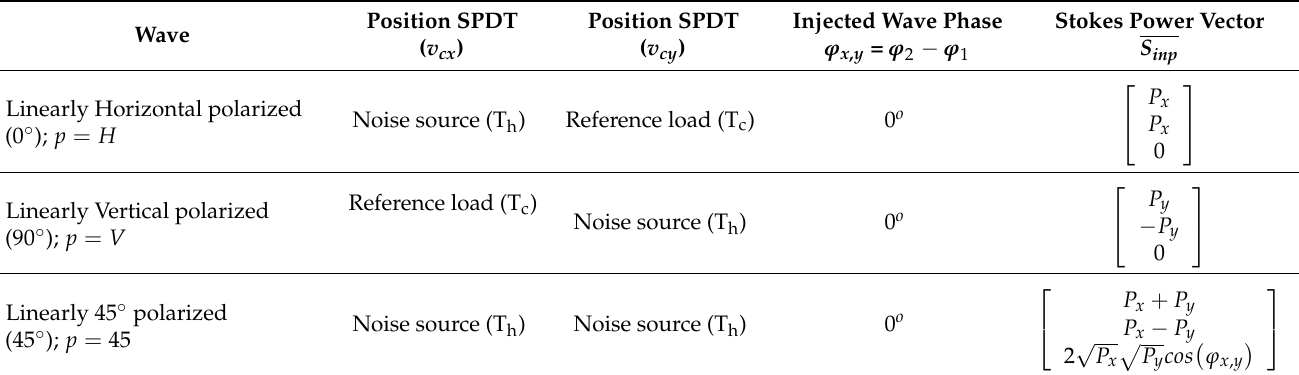
Table 1. Injected polarized waves for